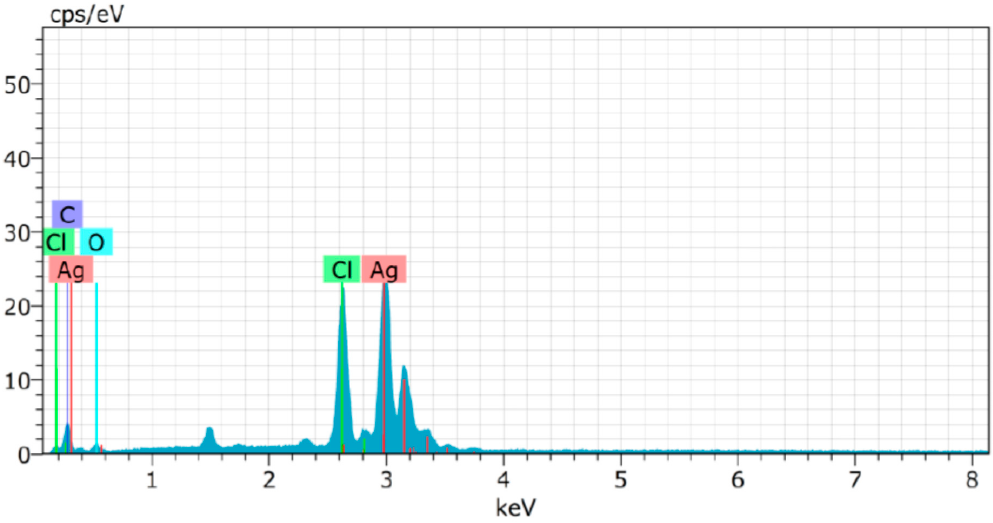
Figure 4. Energy dispersive X-ray (EDX) spectrum analysis of biosynthesized AgNPs showing strong peak at 3 keV for silver.